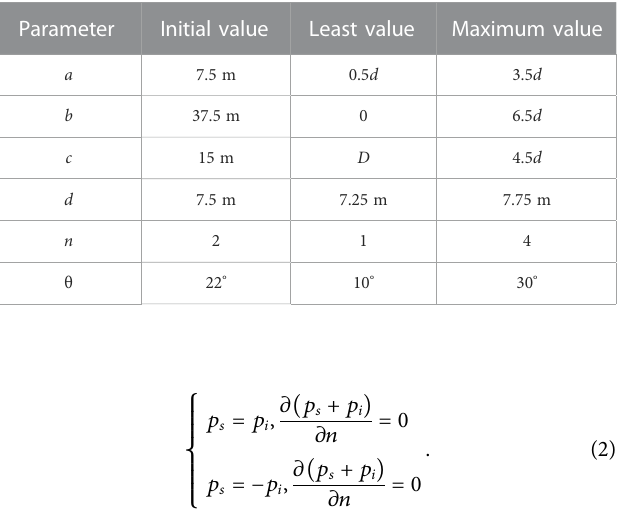
TABLE 1 Optimization variable range settings for